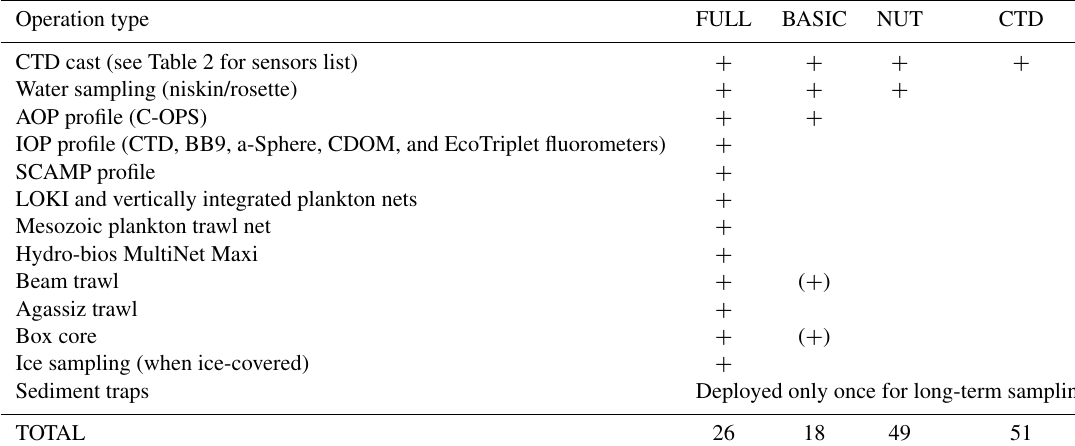
Table 1. List of operations carried out during the Green Edge cruise at each different station type. [( + ) Opportunistic sampling only]. CTD conductivity–temperature–depth; AOP apparent optical properties; C-OPS Compact-Optical Profiling System; IOP inherent optical properties; BB9 backscattering meter; CDOM coloured dissolved organic matter; SCAMP Self-Contained Autonomous MicroProfiler; LOKI Lightframe On-sight Key species Investigation.